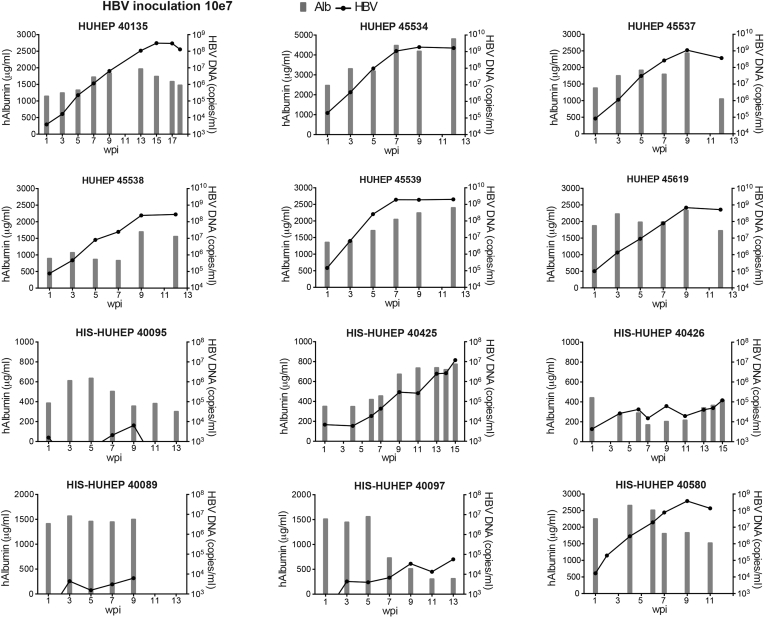
Longitudinal follow-up of HBV viremia (black line) and hAlbumin (grey bars) in the plasma of individual HUHEP and HIS-HUHEP mice inoculated with low-dose HBV 10e7.